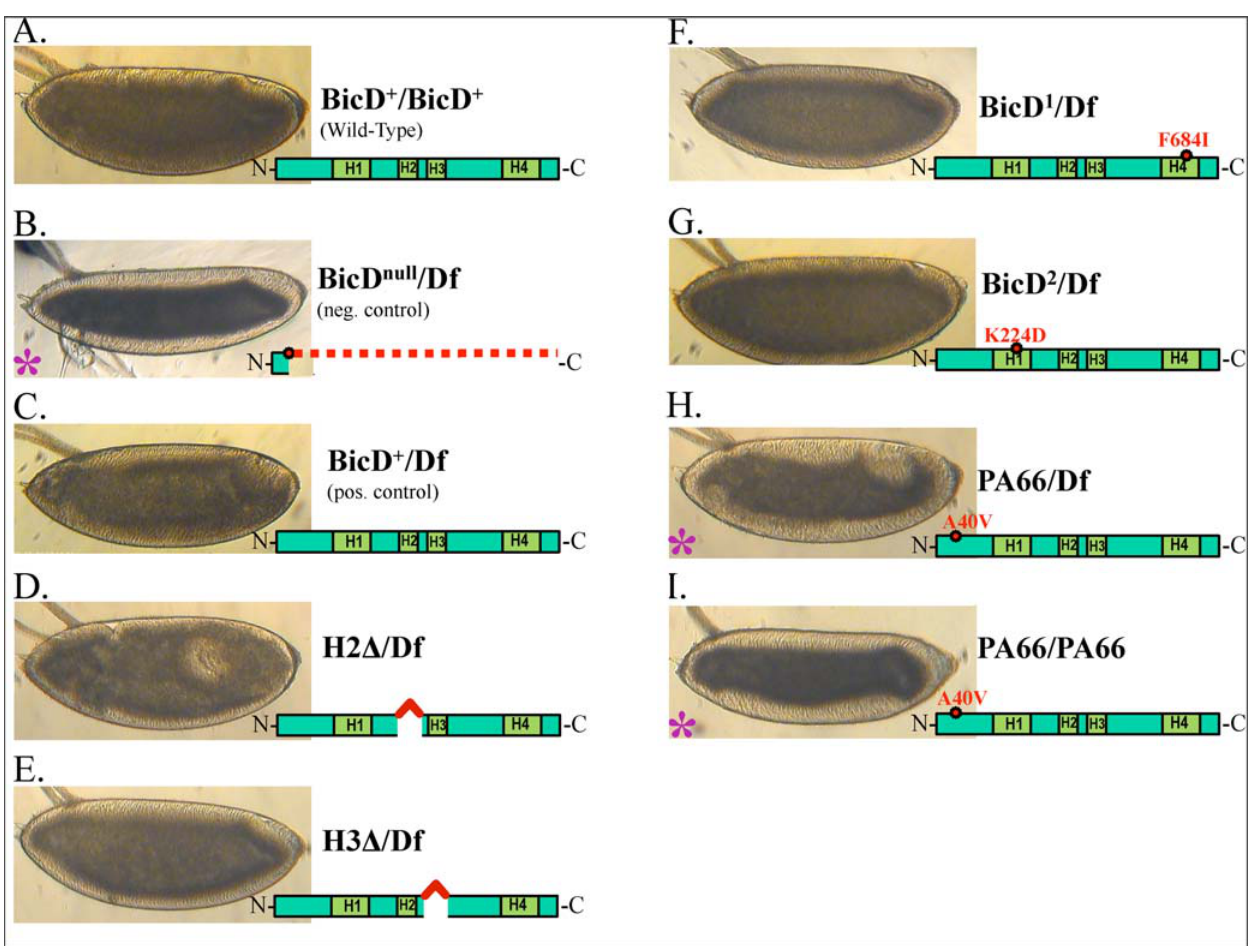
Figure 5. Examining BicD alleles for the ability to rescue the reclouding defect of a low BicD background. A–I: Alleles comprised of domain deletions, point mutations, and premature stop codons were examined. B–C: Negative and positive controls are shown for comparison. All alleles appeared to rescue (C–G), with the exception of the point mutation BicD PA66 (H–I). Rescuing with two copies of BicD PA66 displayed a continued failure to rescue (I). E: On average, there is the suggestion that there may be only a partial rescue phenotype seen in the BicD H3 D rescue background. Images with purple asterisks are those with a BicD-null phenotype.